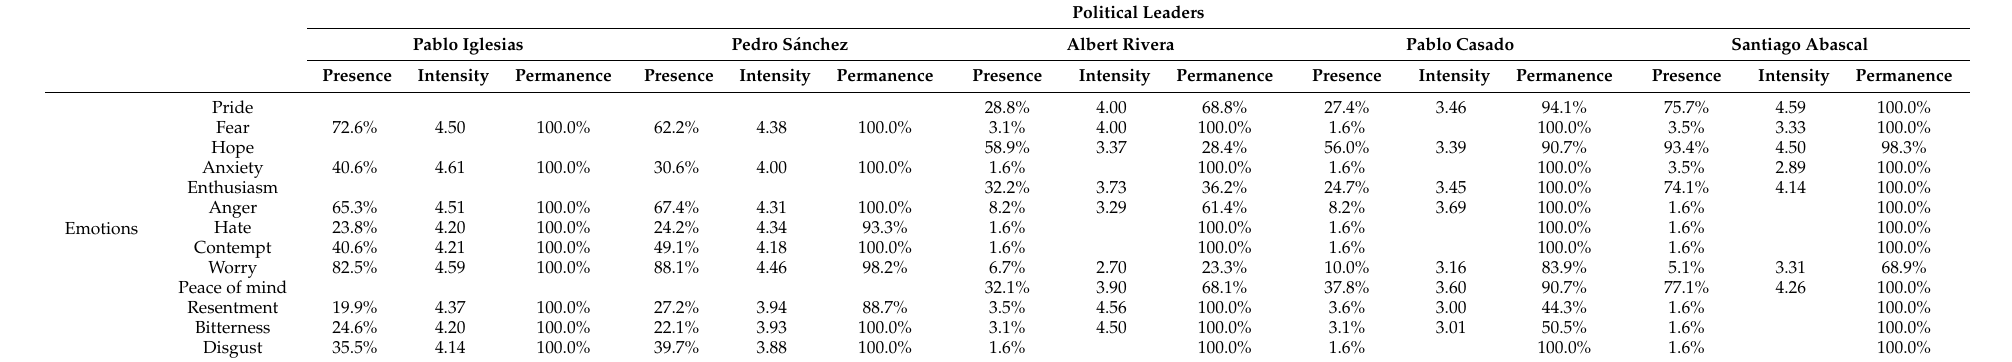
Table 1. Emotions of VOX voters towards political leaders.